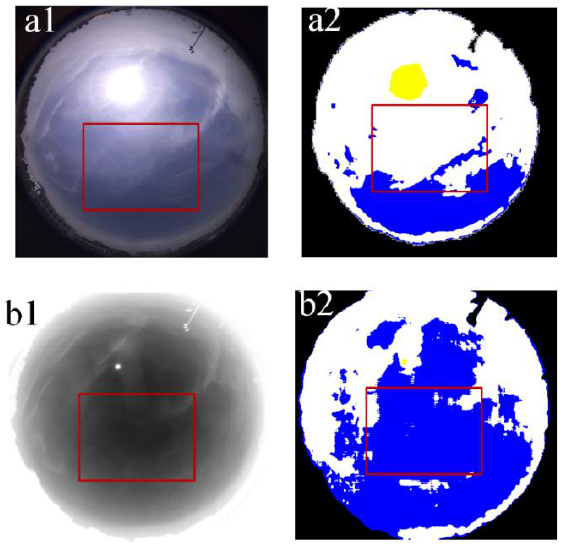
Figure 10. Comparison of the cloud detection results of infrared and visible sky image with cirrus in the sky. ( a1 , b1 ) show the visible and the TIR cloud images, and ( a2 , b2 ) show the results of the cloud identification of the two cloud images.